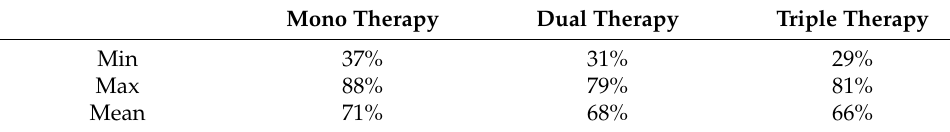
Table 8. MPR of female